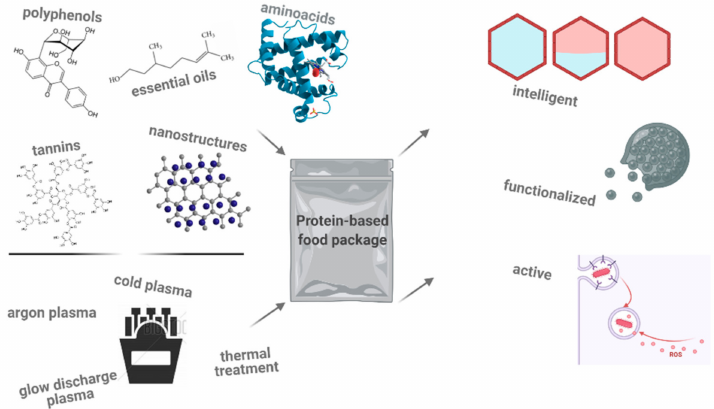
Figure 1. Compounds and technologies that add values to protein-based food